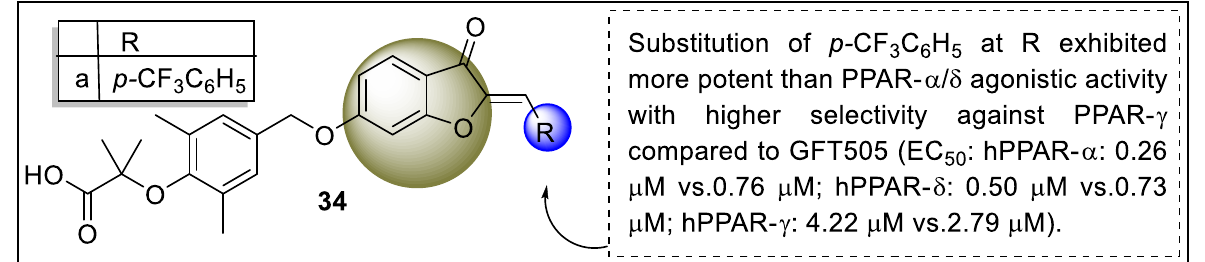
29 of 50 Figure 37. Structural activity relationship of Furan hybrids ( 33 ) as potent PPAR ligands. Recently, Liu et al. synthesized a series of hybrid compounds as dual agonists of PPAR- α/δ. The rationale behind the synthesis was a hybridiz ation of the carboxylic group of GFT505 with the parent motif of sulfuration to generate a low-risk and more potent PPAR ligand. These synthesized candidates were tested for the agonistic activity of hu- man PPARα, δ, and γ by in vitro GAL4 -PPAR transactivation assay on transfected COS7 cells whereas GW7647, GW501516, and rosiglitazone were used as reference. The results